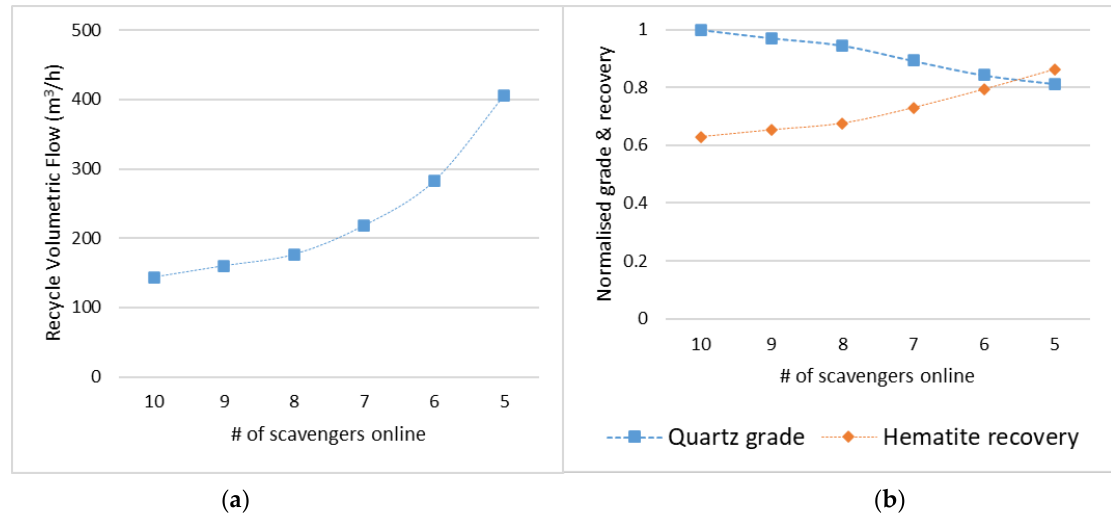
Figure 9. Scenario 3 simulation results highlighting ( a ) the recirculating volumetric flow rate, and ( b ) the normalized quartz grade and hematite recovery of the final concentrate both as a function of the number of online scavenger cells.